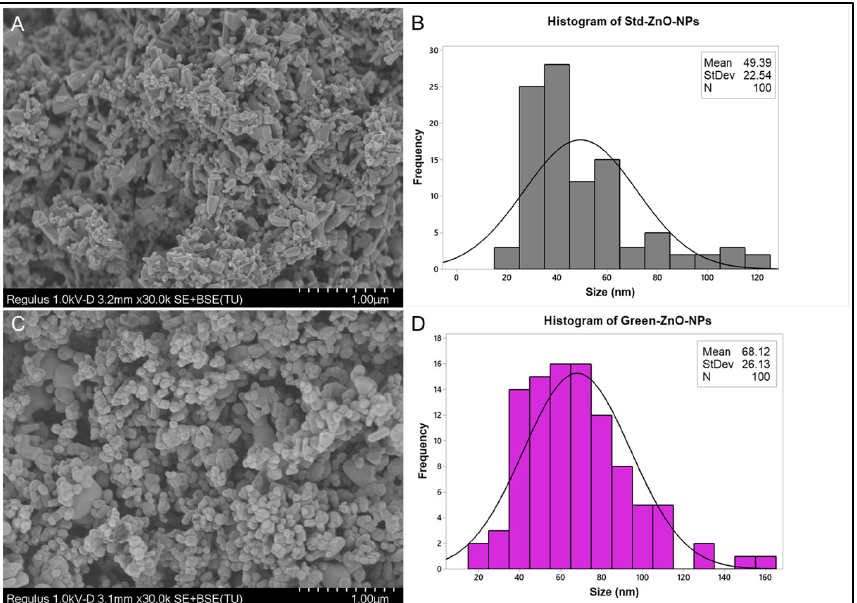
Figure 5. ( A ) Scanning electron microscopy images of Std-ZnO-NPs and ( B ) their corresponding histogram of particle size distribution ( n = 100). ( C ) Scanning electron microscopy images of Green- ZnO-NPs and ( D ) their corresponding histogram of particle size distribution ( n = 100).